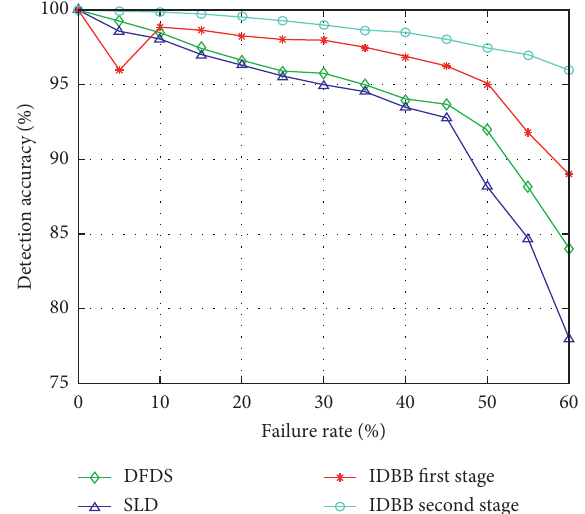
Figure 3: Relationship between detection accuracy rate and failure rate.